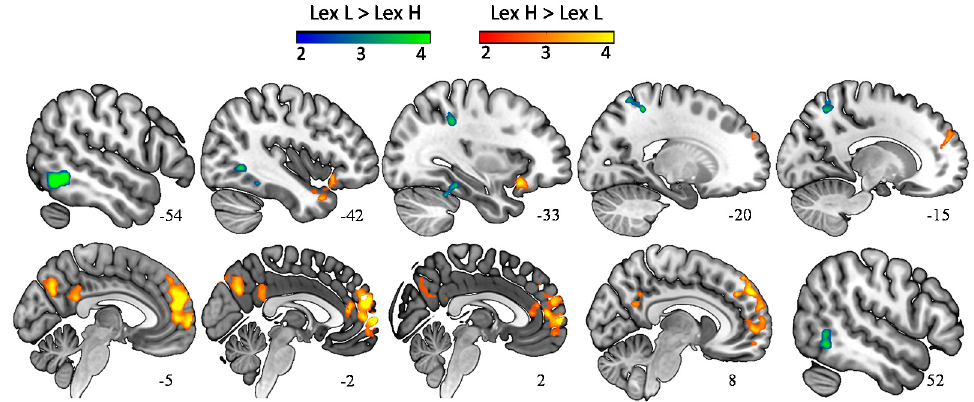
Figure 3. The main effect of sublexical arousal (i.e., words sounding high vs. low arousing) and the related pairwise comparisons were associated with an enhanced BOLD signal in bilateral posterior insula, superior temporal cortex (BA 22 extending to BA40), as well as supplementary and primary motor cortex (BA 6) ( p < 0.05, FWE-corr.). 4. Discussion The current study investigated the neural correlates underlying the affective potential of a word’s sound and whether brain regions involved in processing emotional vocalization and affective prosody are also used to process affectivity in the sound of a word. The overall activation observed for the effect of lexical arousal (Lex H > Lex L) is in accordance with previous findings showing the involvement of dorsolateral and medial prefrontal cortex, as well